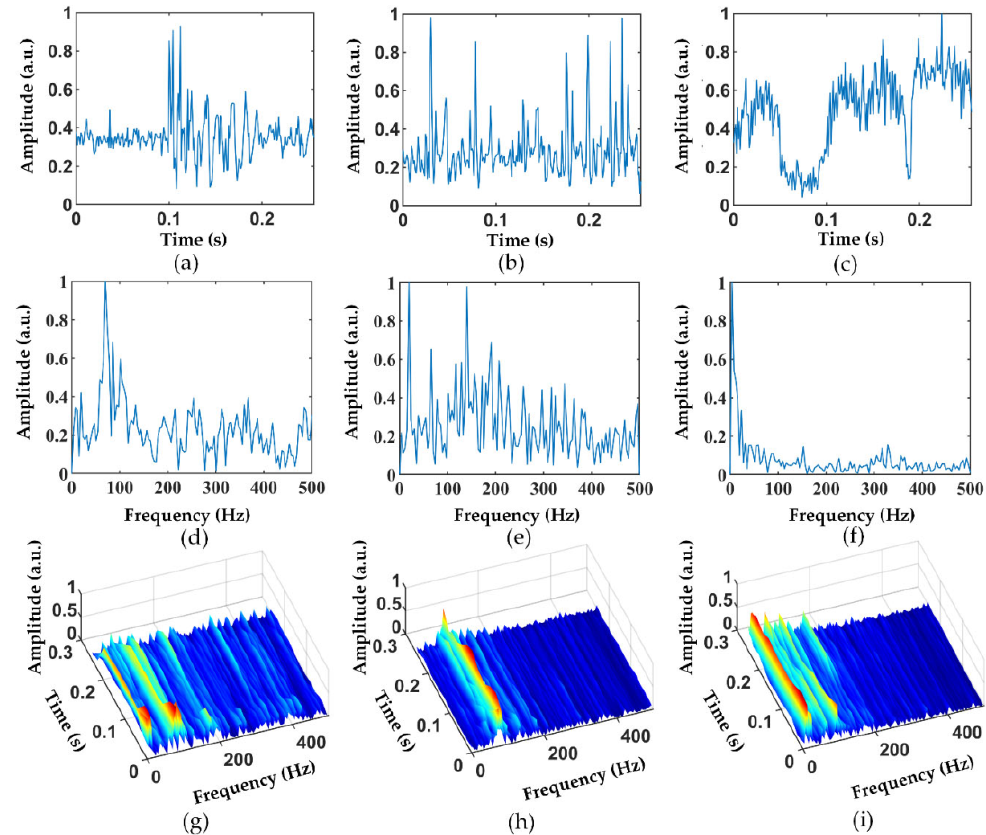
Figure 5. ( a – c ) Time-domain diagrams of a hammer, air pick, and excavator; ( d – f ) frequency-domain diagrams of a hammer, air pick, and excavator; and ( g – i ) time–frequency domain diagrams of a hammer, air pick, and